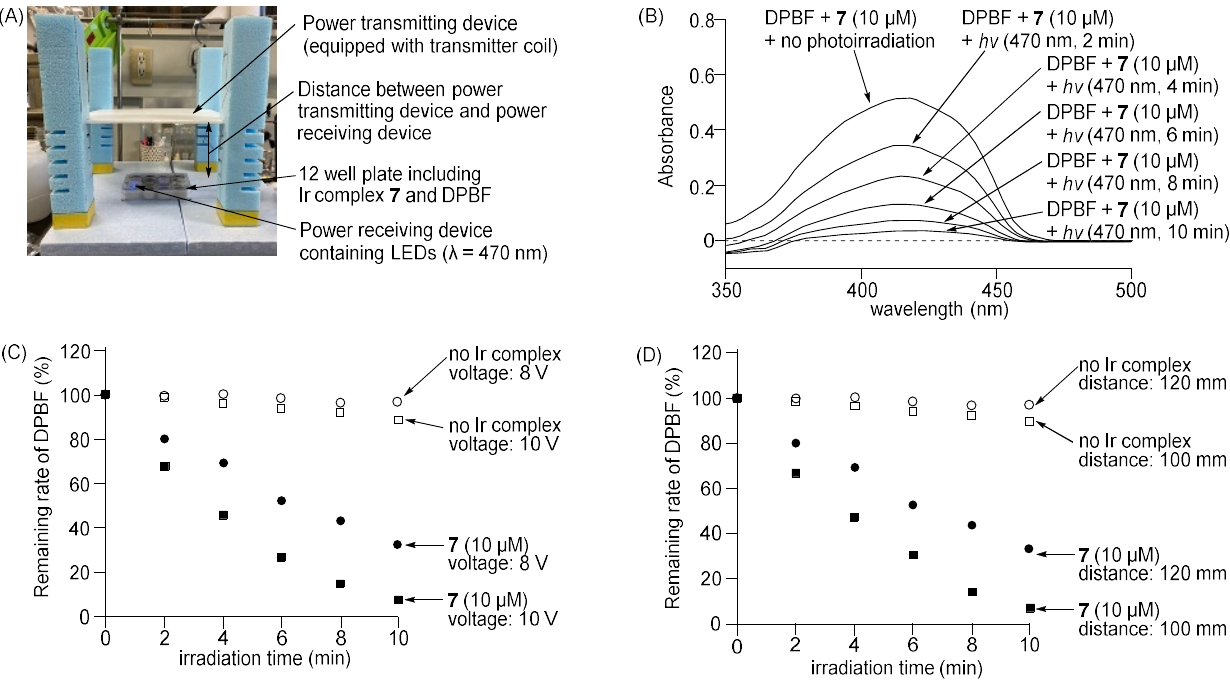
Figure 4. ( A ) Experimental equipment used for WPT. ( B ) UV spectra of DPBF (50 µ M) upon the photoirradiation (470 nm) of 7 (10 µ M) in DMSO/H 2 O (3/2) including HCl (50 µ M) in the WPT system for 0–10 min at 10 V at a distance of 120 mm between the PT and PR. ( C ) Effect of voltage on the photooxidation of DPBF (50 µ M); ( # ) 8 V and ( □ ) 10 V in the absence of 7 (10 µ M), ( • ) 8 V, and ( ■ ) 10 V in the presence of 7 (10 µ M). The distance between the PT and PR was 120 mm. ( D ) Effect of distance between the PT and PR on the photooxidation of DPBF (50 µ M); ( # ) 120 mm and ( □ ) 100 mm in the absence of 7 (10 µ M), ( • ) 120 mm and ( ■ ) 100 mm in the presence of 7 (10 µ M) at 8